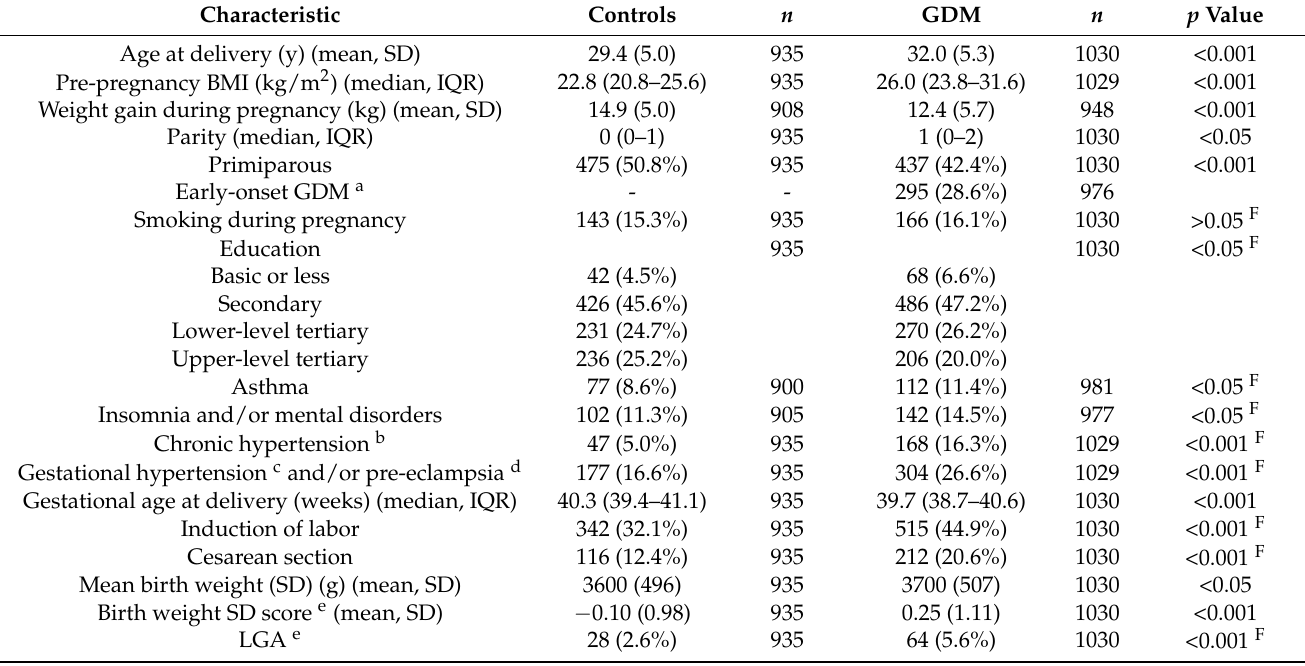
Table 1. Maternal and perinatal characteristics of the participants ( n =